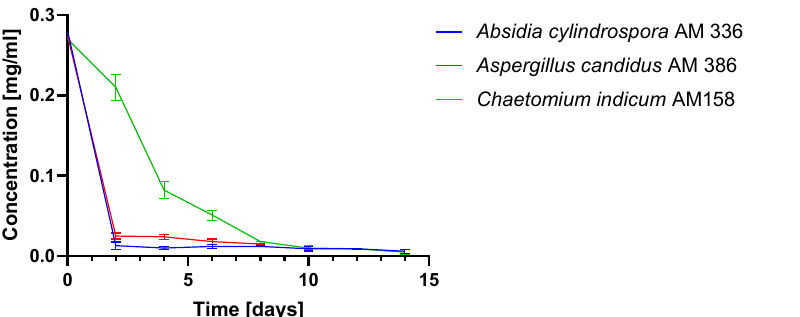
Figure 4. Change in 3- n -butylidenephthalide ( 1 ) concentration during scale-up biotransformation determined by gas chromatography.